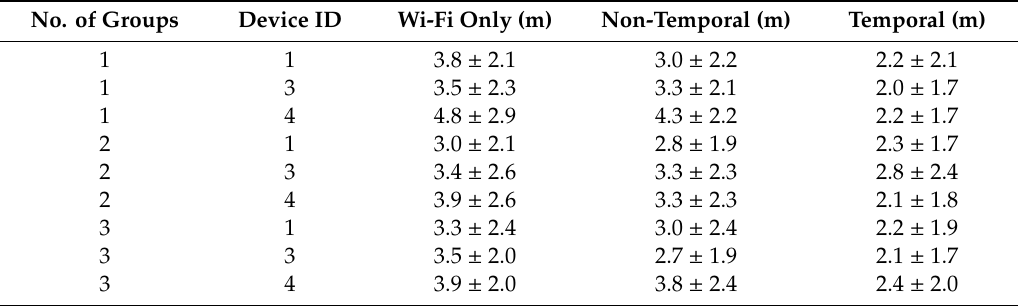
Table 6. Average positioning errors per device for three-user experiments.